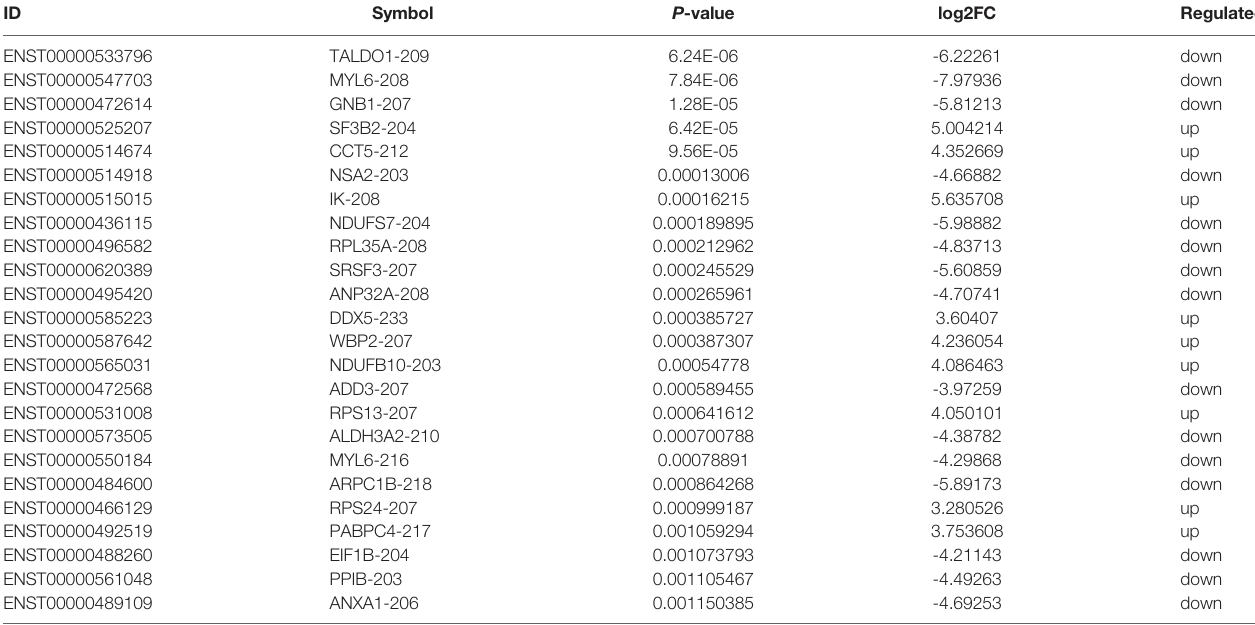
TABLE 3 | The detailed information of the differentially expressed exosomal